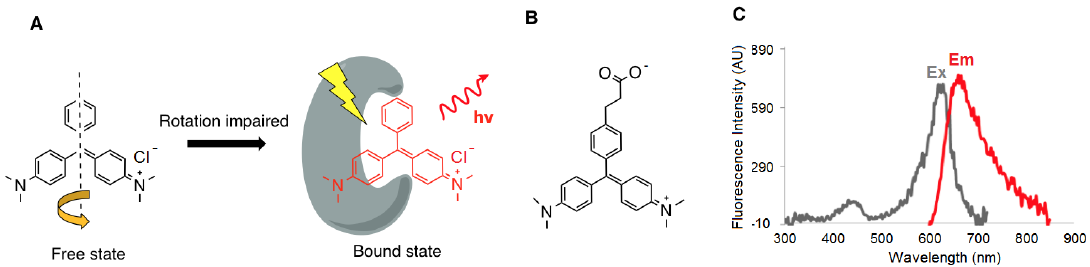
Figure 1. ( A ) Molecular rotor dye (MRD) malachite green (MG) in free and bound states. ( B ) Structure of the carboxyethyl malachite green (CEMG). ( C ) CEMG excitation, emission spectra were obtained in glycerol:PBS (80:20, v / v ) at pH 7.4.